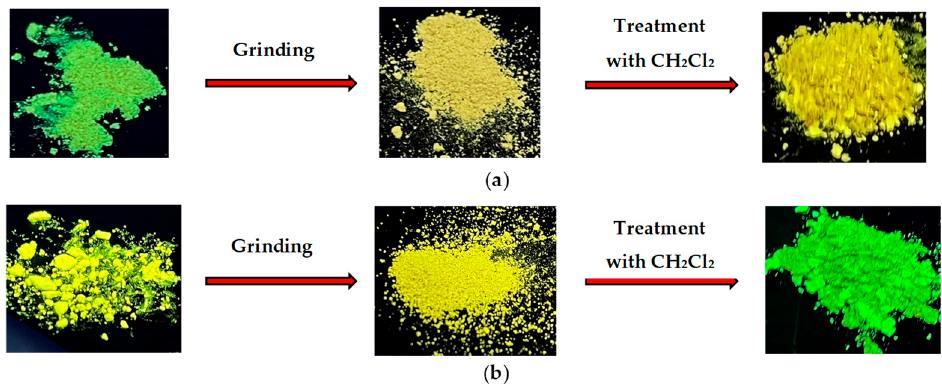
Figure 7. Photographs of 6c ( a ) and 6f ( b ) taken under 365 nm UV irradiation.